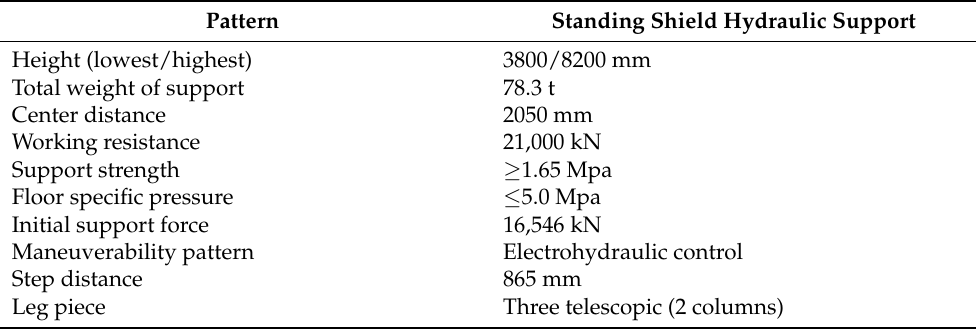
Table 4. Main Parameters of ZY21000/38/82D Hydraulic Support.